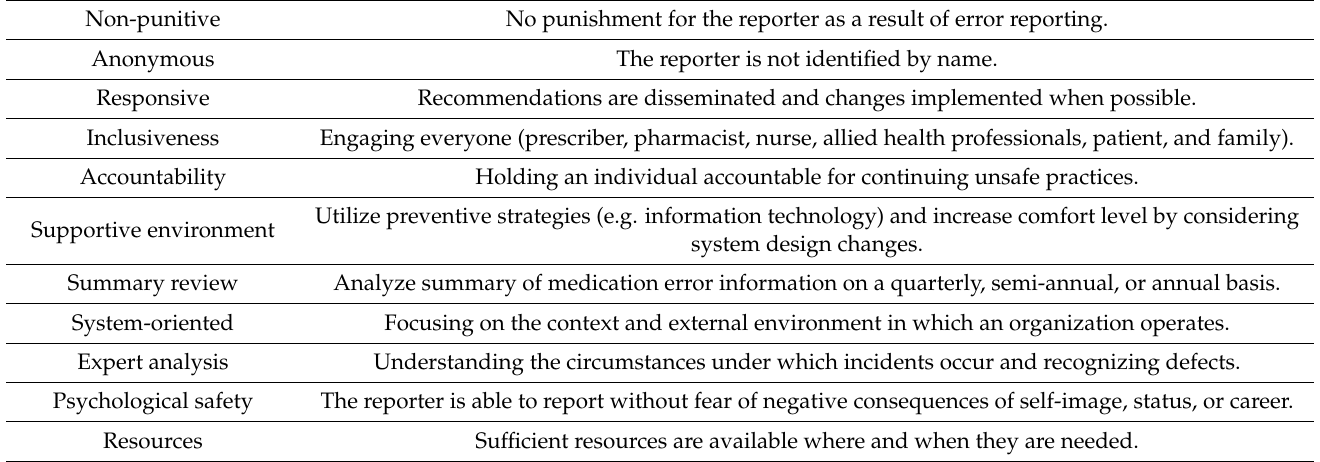
Table 1. Characteristics of Successful Reporting